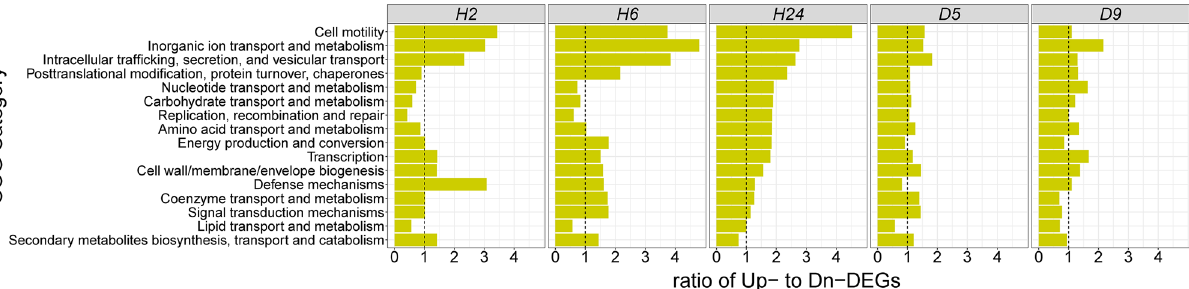
Figure 3. Ratio of up- to down-regulated PAO1 genes in COG categories at different times of wound infection vs. in culture. The COG categories are arranged from top to bottom by the highest to the lowest ratio of significantly up- to down-regulated genes at hour 24